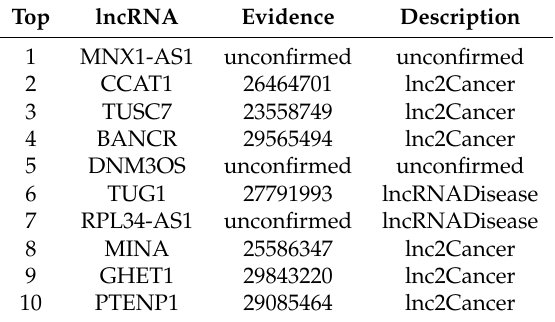
Table 4. The top ten lncRNA candidates for breast